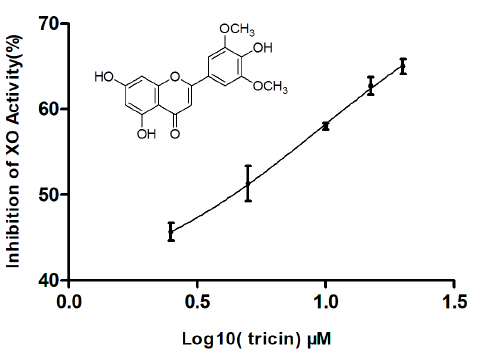
Figure 4. XO inhibitory activity of tricin. Data represent mean ± S.D. of triplicate experiments. Structure of tricin was shown in the inset.